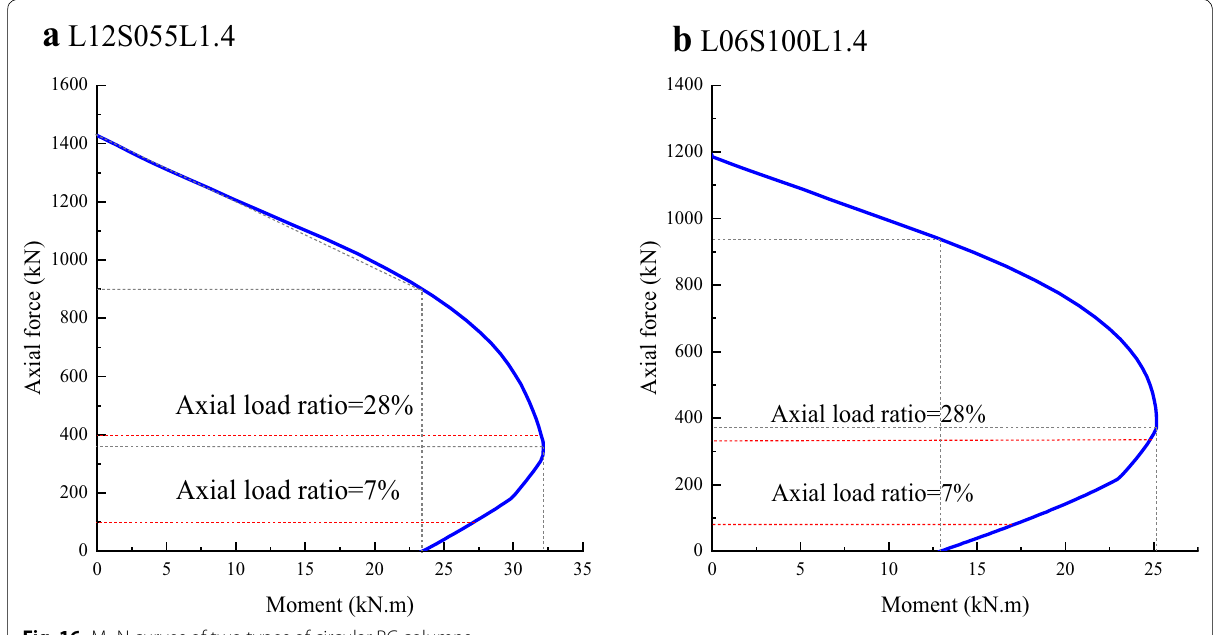
Fig. 16 M–N curves of two types of circular RC